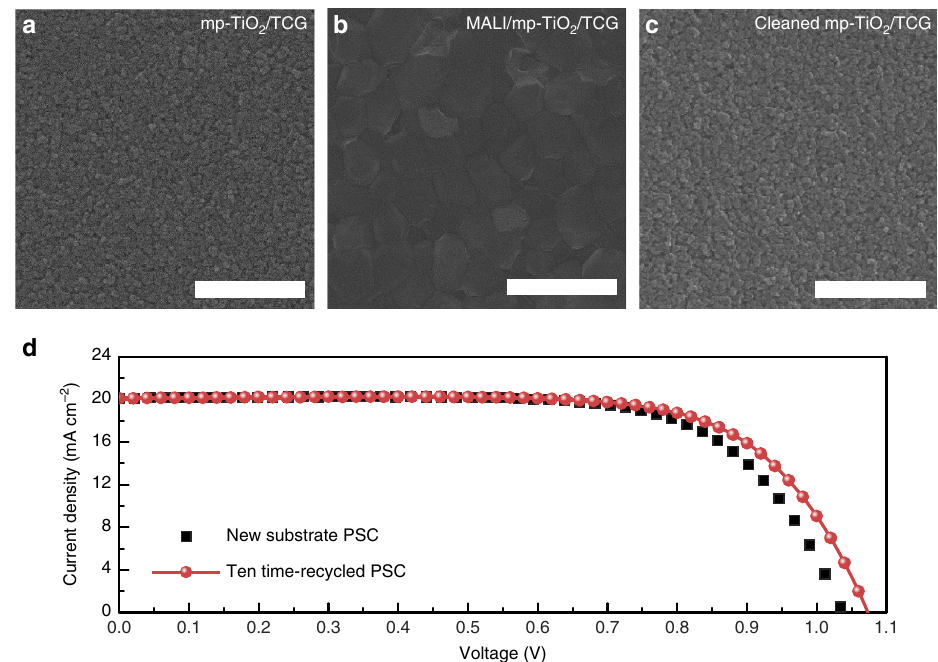
Figure 2 | Features of the recycling process performed via selective dissolution. Plane-view FESEM images of ( a ) a new mesoporous TiO 2 (mp-TiO 2 )/ TCG substrate, ( b ) a CH 3 NH 3 PbI 3 (MALI)-layer-deposited mp-TiO 2 /TCG substrate and ( c ) a cleaned mp-TiO 2 /TCG substrate after the selective dissolution process. For the cleaning of the MALI/mp-TiO 2 /TCG substrate, DMF was used. Scale bars, 1 m m. ( d ) Current density–voltage ( J–V ) curve of a PSC fabricated on a 10-times-recycled mp-TiO 2 /TCG substrate compared with that of a PSC fabricated on a new substrate.